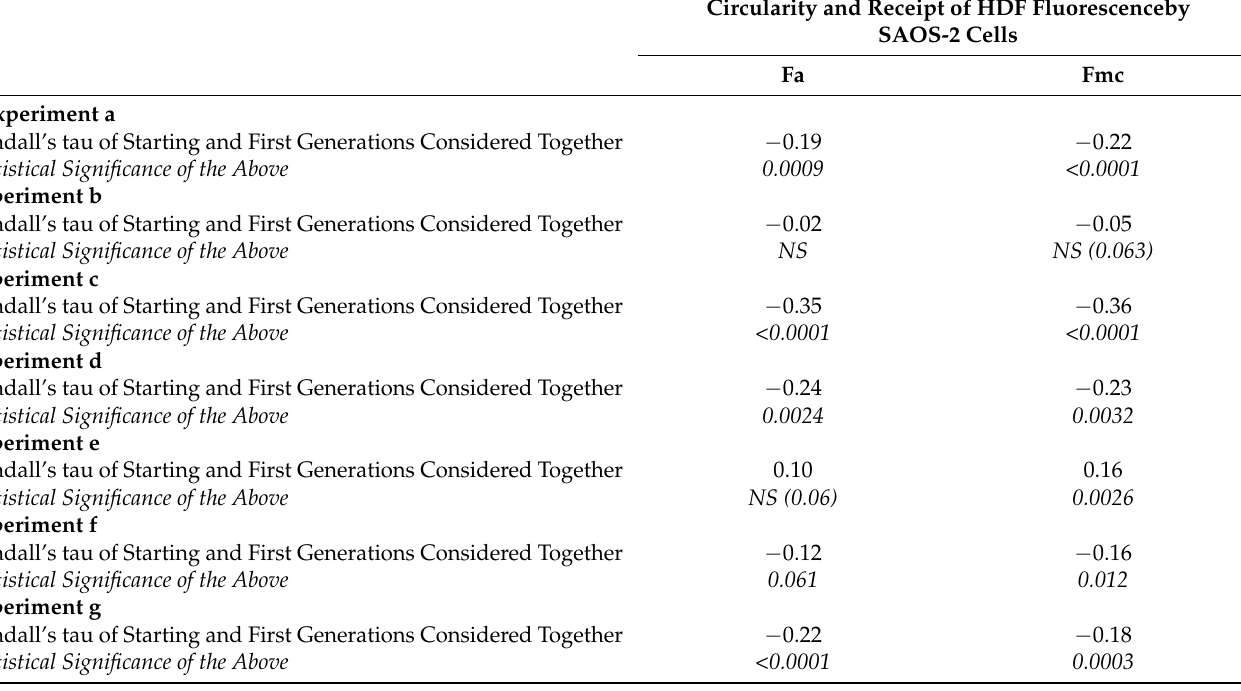
Table 2. Kendall’s tau of correlation between cell circularity of tracked SAOS-2 cells and absolute fluorescence acquired from co-cultured HDFs (Fa), as well as compensation for halving of fluorescence from mother cells by cell division (Fmc). Results for all experiments are shown, considering starting and first generations together. Results for other groupings of successive generations of cells are in the Supplementary Materials, Table S7. Statistical significance is given, where NS indicates ‘not significant’ at p < 0.05. Where statistical significance was approached but not reached, the calculated p -value is given ( NS (p-value)